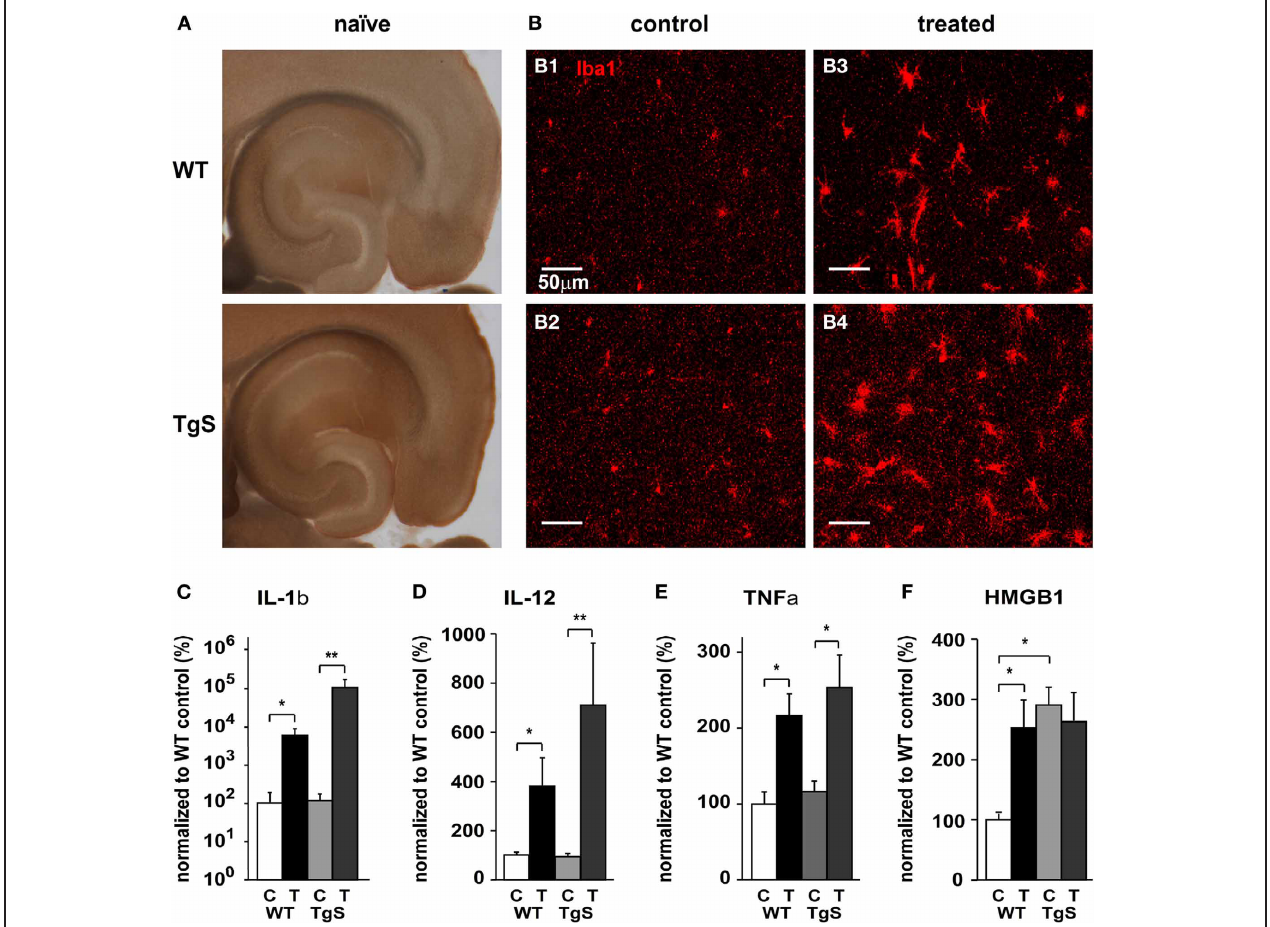
relative levels ( ∗ p = 0.014; ∗∗ p = 0 . 004). (E) TNF α mRNA relative levels. WT: p = 0.027, TgS: p = 0.054. (F) HMGB1 mRNA relative levels. p < 0 . 05 (see text). (WT: n = 5 controls, n = 4 treated, TgS: n = 6 controls/treated. In F; TgS control: n = 4; C, control; T, treated; Statistical analysis was done using the non-parametric Mann–Whitney test, mean